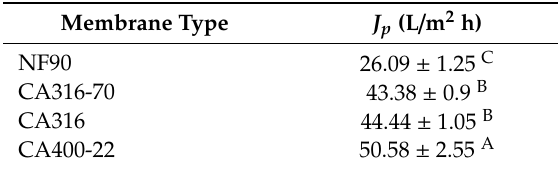
Table 5. Average permeate flux for selected membranes in the nanofiltration of red grape pomace extract (operating conditions: pressure, 20 bar; temperature, 25 ± 1 ◦